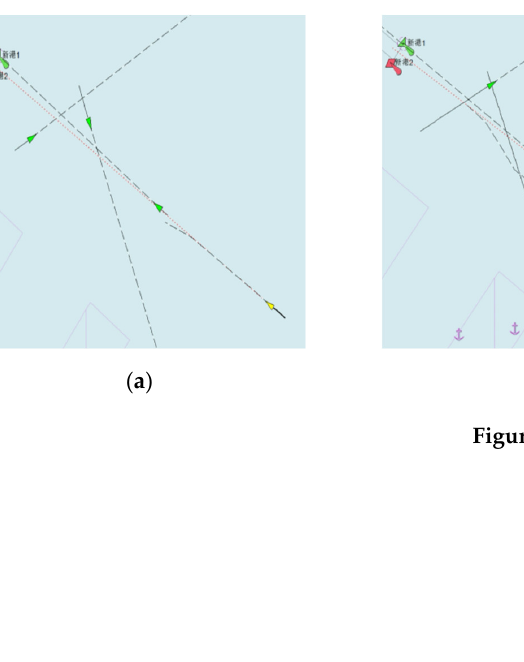
Table 7. Initial information (multi-ship encounter in a busy sea area).